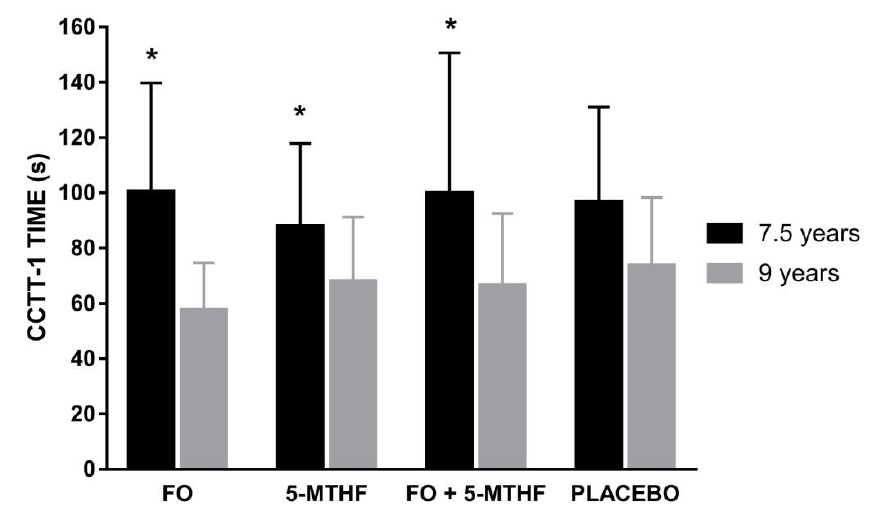
Figure 2. Effects of prenatal supplementation on CCTT-1 test in children at 7.5 and 9 years. Level of significance was obtained from one-way ANOVA. * Significant differences between 7.5 years and 9 years were observed in time spent (s) to solve the CCTT - 1 test between children whose mothers were supplemented with FO ( p = 0.0001), 5-MTHF ( p = 0.0113) or both treatments (FO + 5MTHF) ( p = 0.038) during pregnancy. 5-MTHF: 5-Methyltetrahydrofolate; CCTT-1: Children´s Color Trails Test; FO: fish-oil.